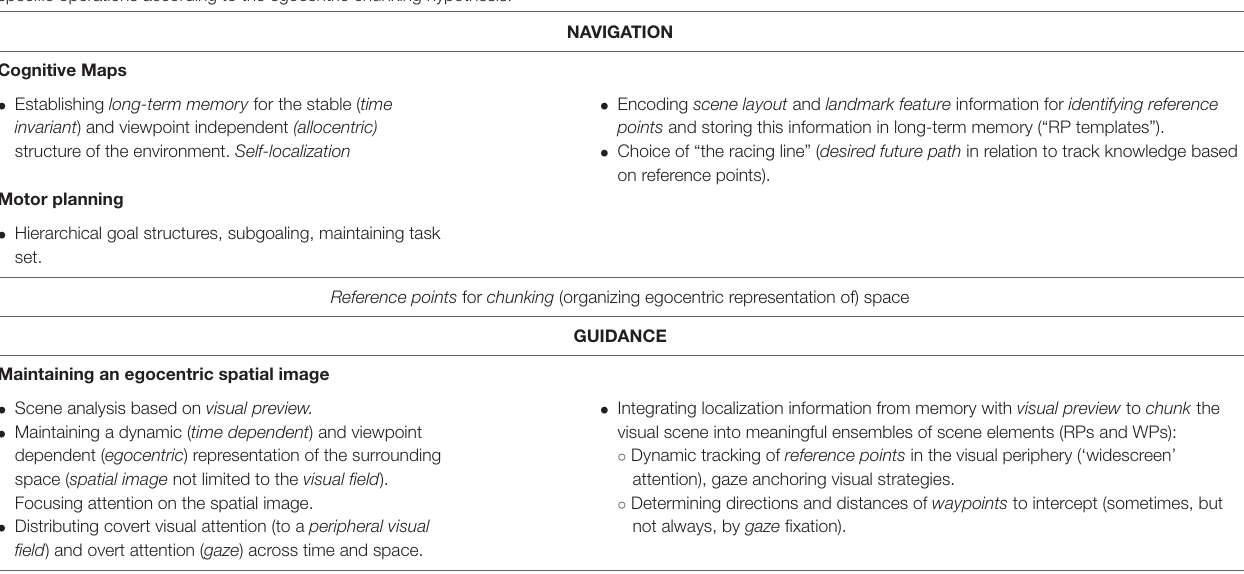
TABLE 2 | Left column : cognitive processes stated in the general, as described in the cognitive psychology and neuroscience of wayfinding and steering; Right column : specific operations according to the egocentric chunking